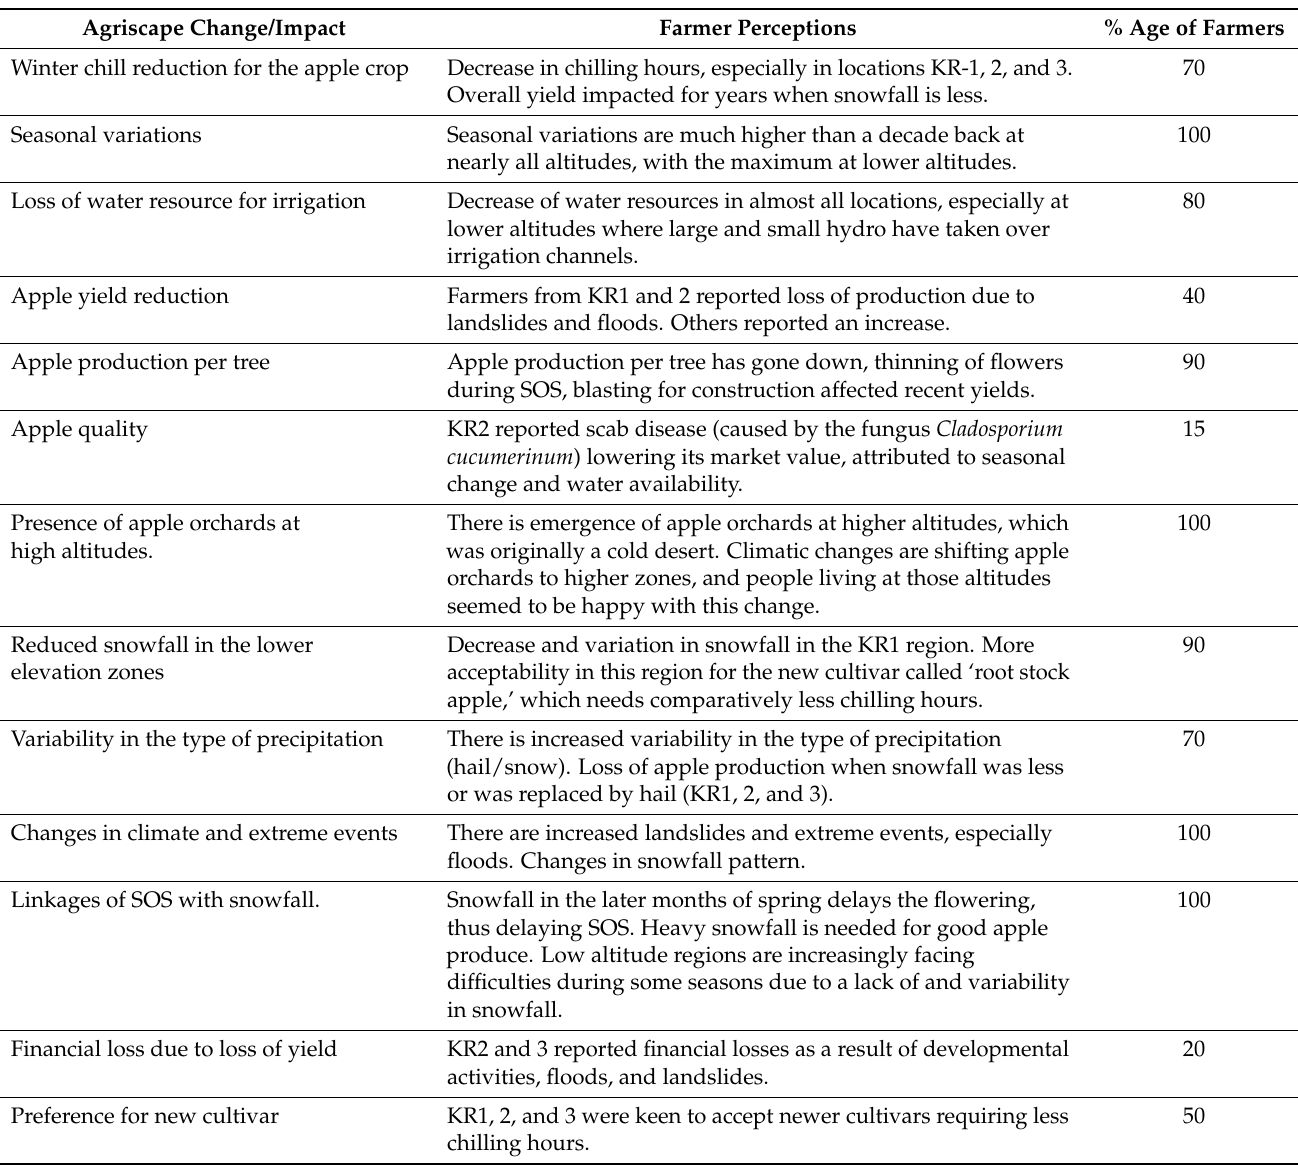
Table 1. Farmers’